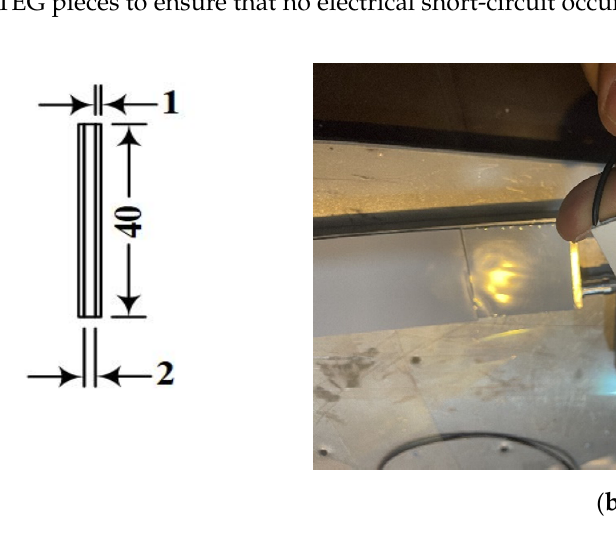
Figure 7. Thermal paste, arrays and insulators used in the panel. The significant difference between this system and solar panels is that the former can be used continuously during the day and night hours. This is unlike solar systems that operate during daylight hours because they depend only on solar radiation. 2.3. Electrical Connections and Data Measurements In practice, many measuring devices were used during the experiment (digital clamp meter, a single-end glass seal (NTC) thermistor temperature sensor, digital temperature humidity meter) integrated with a microcontroller to obtain more accurate results . Heat sensors (thermocouples) are attached at various places on the panel to determine the tem- perature distribution on the test panel. All of the mentioned sensors here are sending their measurement signals to an Arduino Mega which is shown in Figure 8.